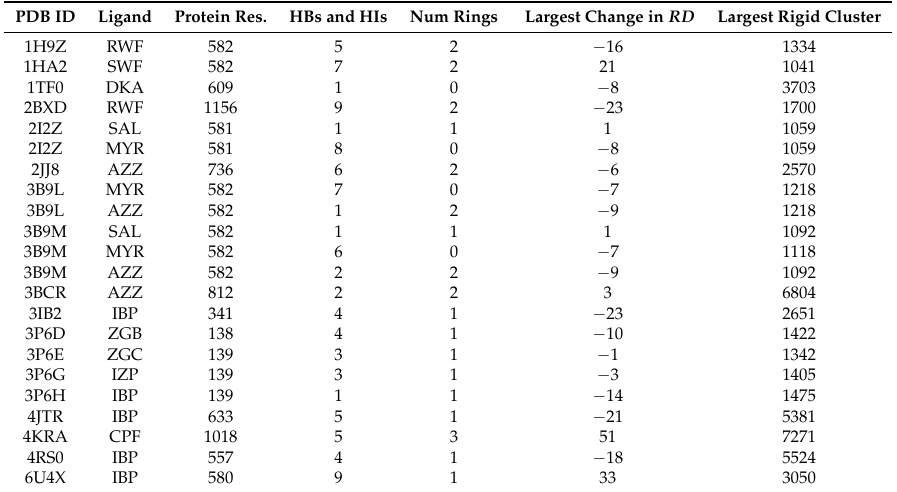
Table 1. Twenty-two of the 32 protein-ligand complexes analyzed using PETRA.